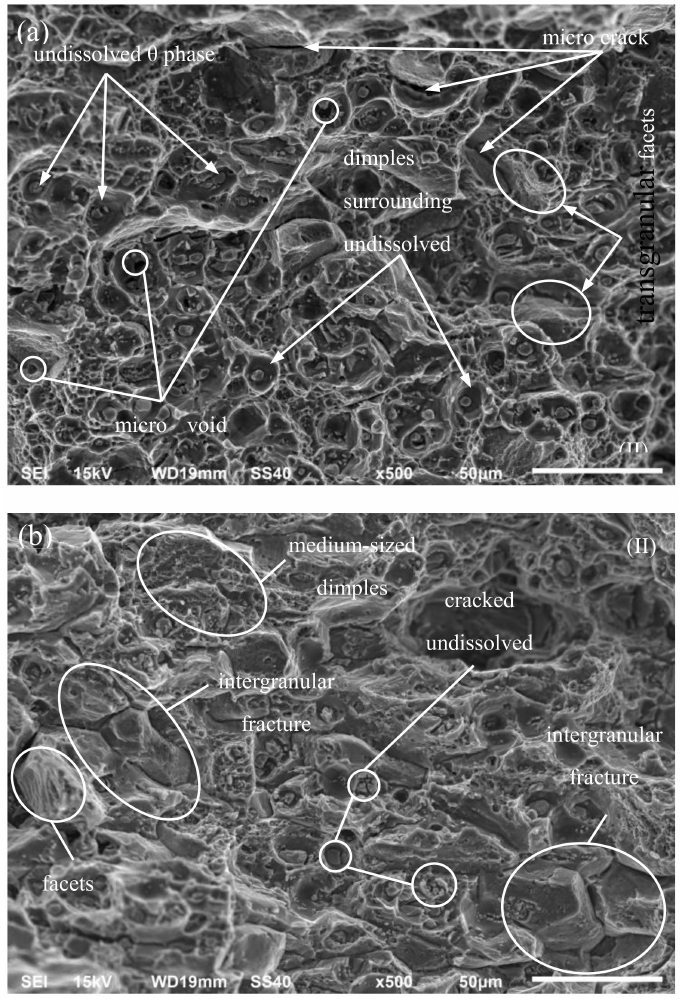
Figure 8. Image of the AA2519 ( a ) fracture obtained in tests performed at 293 K and ( b ) fracture generated in tests performed at 77